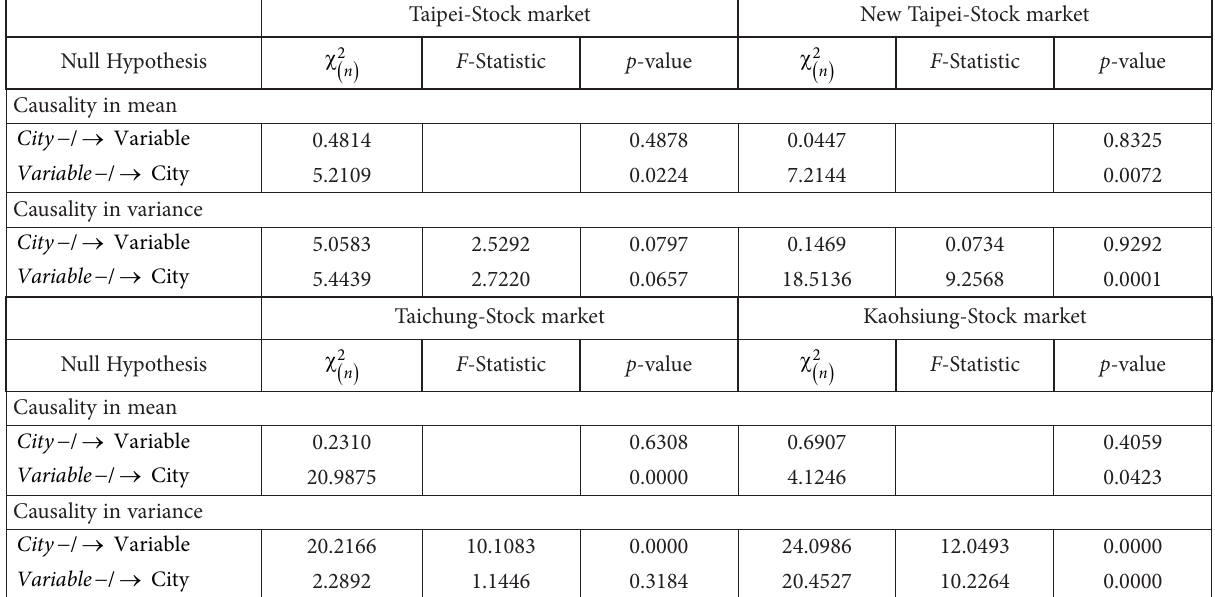
Table 12. Relationship between the stock and housing markets Taipei-Stock market New Taipei-Stock